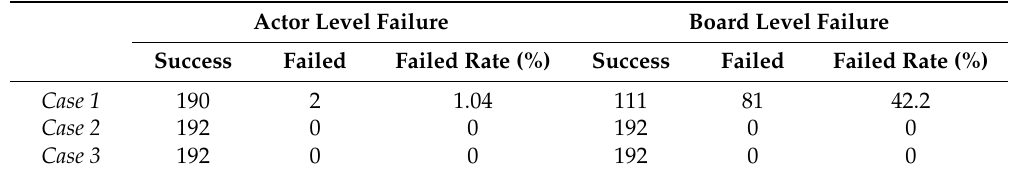
Table 5. The failure rates of the three cases.